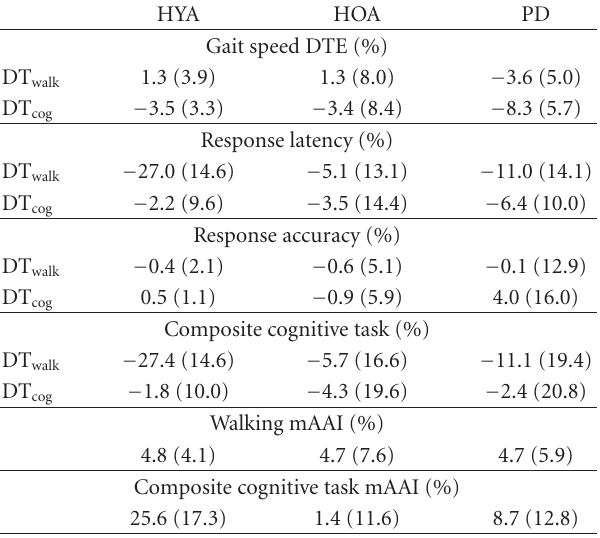
Table 3: Mean (SD) values for dual-task e ff ects (DTE) and modified attention allocation index (mAAI) for walking and the cognitive task measures in all